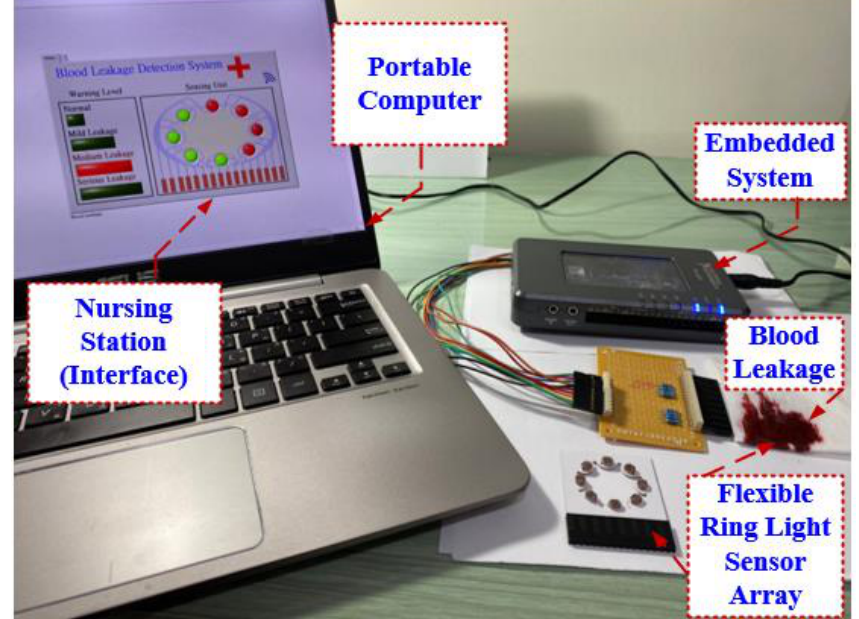
Figure 7. Experiment setup and sensor array detection results. Table 1. Mean results of 10 experiments using artificial blood (2–10